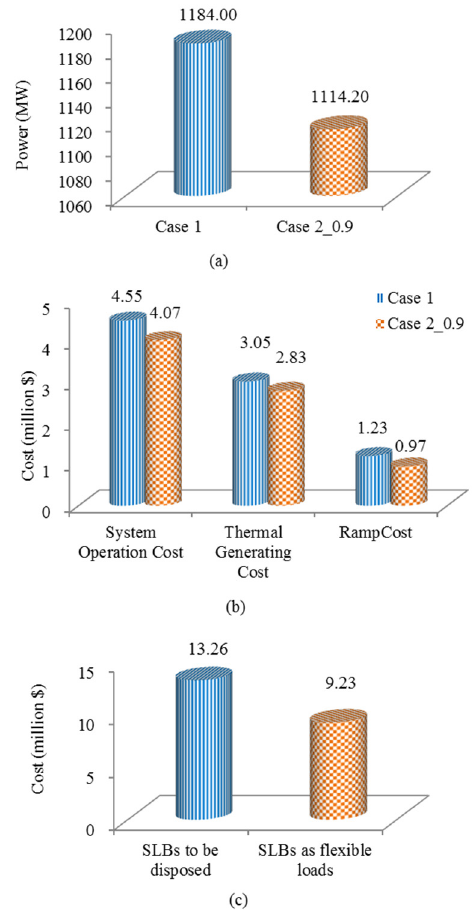
Figure 10. Result comparisons of Case 1 and Case 2 with 0.9 confidence degree. ( a ) is load peak-valley differences; ( b ) is system operating cost, thermal power generating cost and thermal generator ramp cost and ( c ) is the OC of SLBs to be disposed of and used as flexible loads.